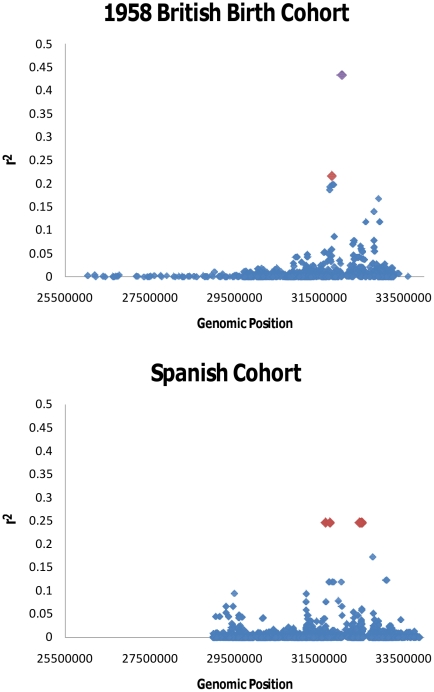
Correlation between C4 exon 29 CT insertion and flanking MHC SNPs and HLA-DRB1 alleles.The correlation coefficient, r2, between the C4 exon 29 CT insertion and flanking MHC SNPs and HLA-DRB1 alleles is shown. Data for the United Kingdom cohort is illustrated in the top panel while that for the Spanish cohort is shown in the bottom panel. The sizes of the diamonds are inversely proportional to the p values for each SNP or HLA-DRB1 allele. Purple diamonds indicate r2>0.4, red diamonds indicate r2>0.2 but <0.4, blue diamonds indicate r2<0.2.